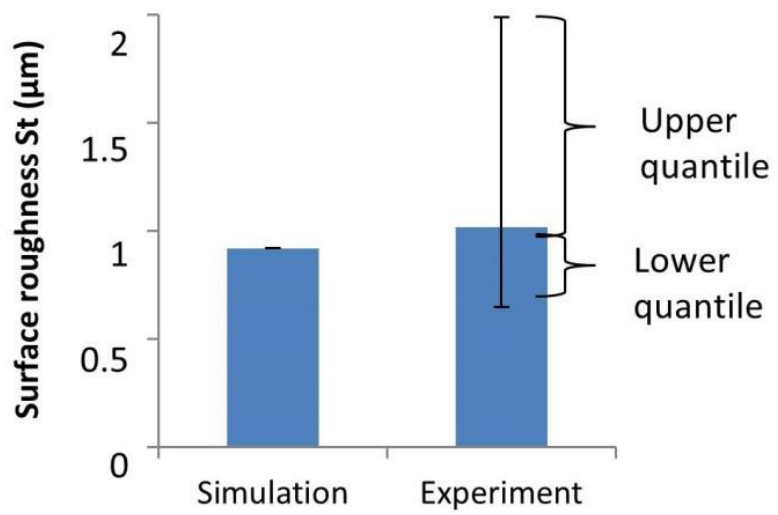
Figure 5. Surface roughening by 5% strain of five different states of strain.